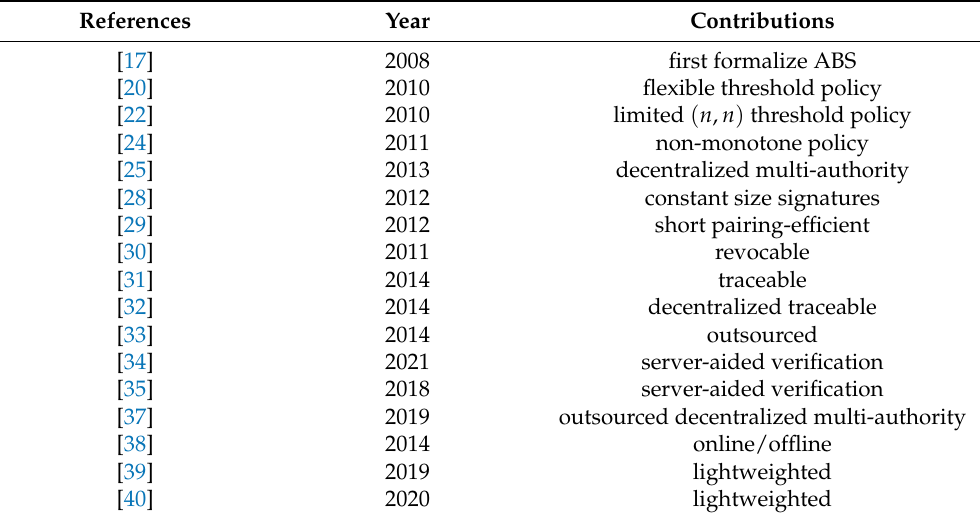
Table 1. A summary of some related